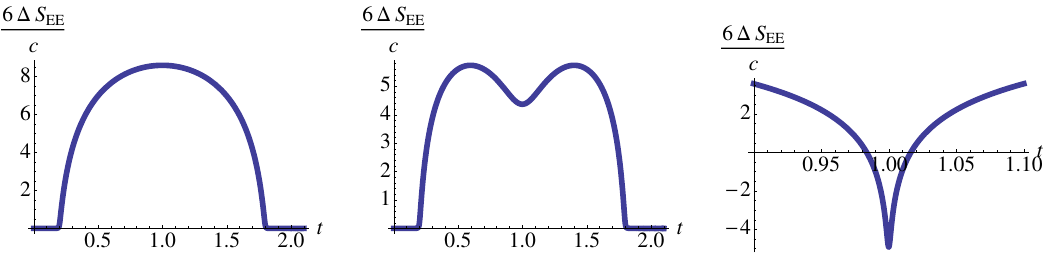
Figure 2 . The change in holographic entanglement entropy following a local quench by an operator carrying spin-three charge in SL(3 ; R ) (cid:2) SL(3 ; R ) Chern-Simons theory. The quench width is (cid:15) = 0 : 008, (cid:12) = 5 : 5, ‘ 1 = 0 : 2, ‘ 2 = 1 : 8, and (cid:1) O =c = 0 : 5. The (cid:12)gure on the left has q=c = 0, the central one corresponds to q=c = 2 : 884 whilst the rightmost one depicts the onset of a divergence at a critical value q=c (cid:25) 2 :